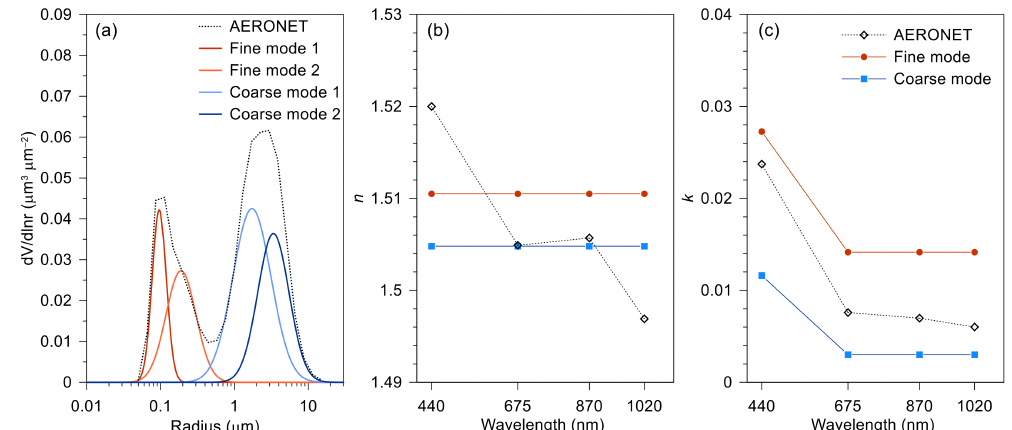
Figure 2. ( a ) The AERONET volume size distributions and corresponding breakdown results according to fine- and coarse-mode peak fitting. Estimated wavelength-dependent complex refractive indices for both fine and coarse modes; ( b ) real and ( c ) imaginary parts. Red circles and blue squares with a solid line indicate the estimated complex refractive index for the fine and coarse modes, respectively. Open diamonds with a dotted line represent data retrieved from